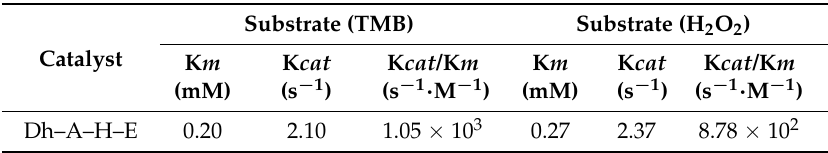
Table 1. The catalytic efficiency of